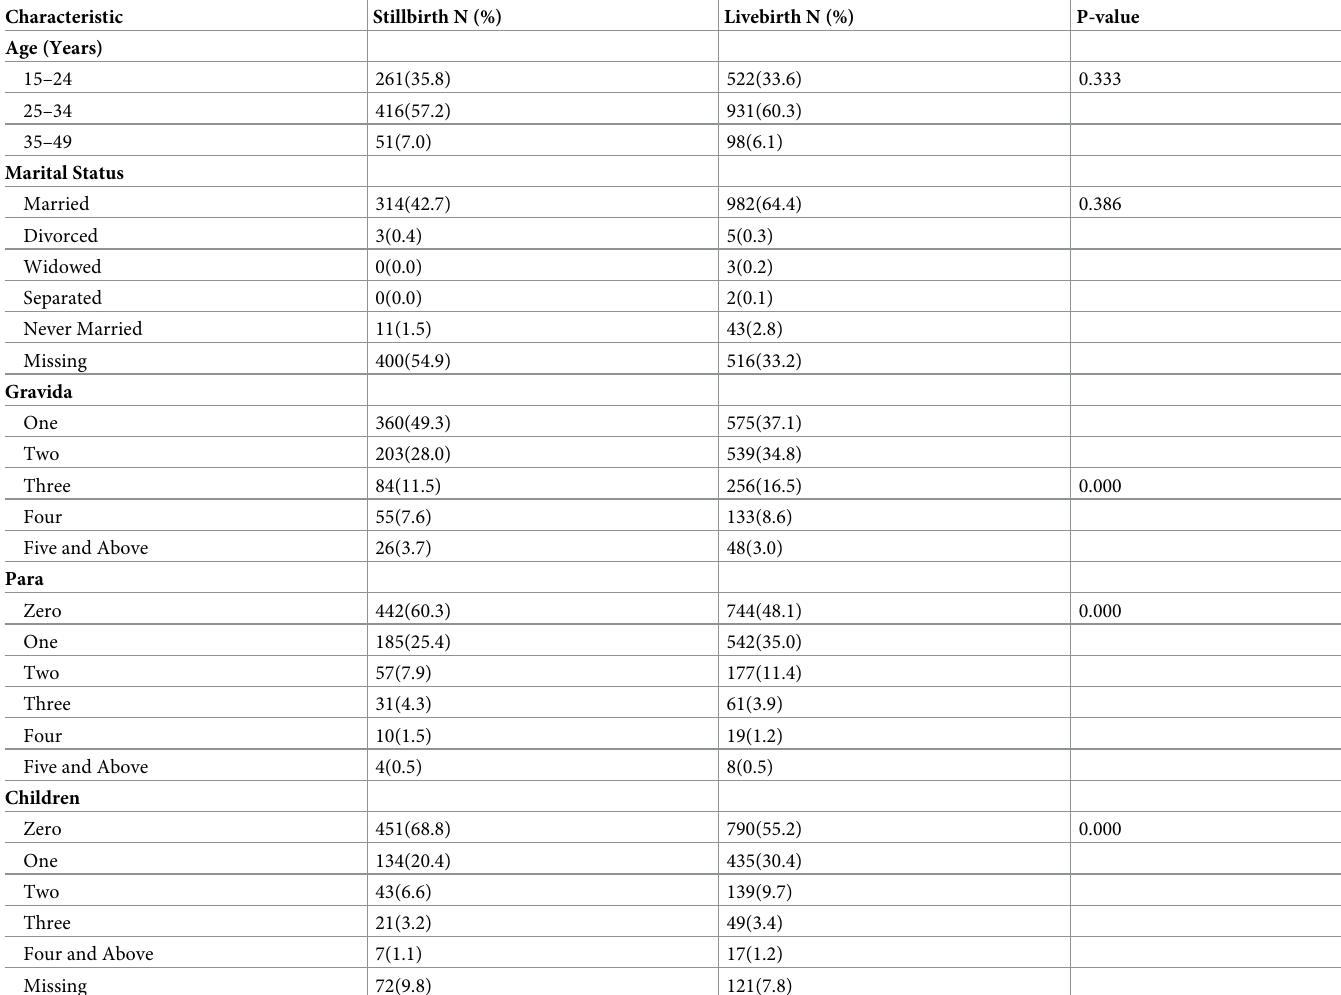
Table 1. Distribution of socio-demographic characteristics among cases and